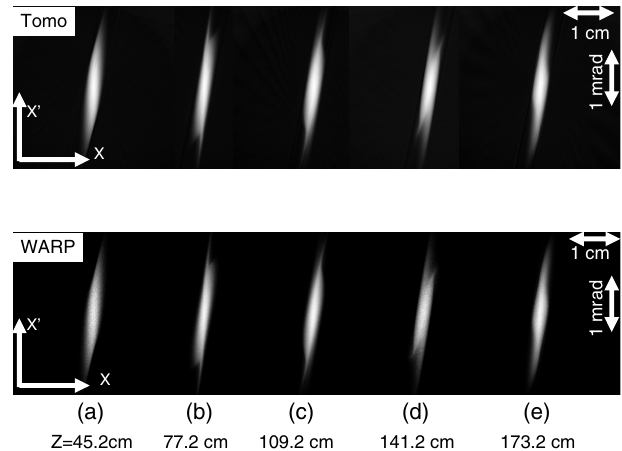
FIG. 10. Phase space from simulations of the 7 mA beam after propagating for different distances, clearly indicating the propa- gation of transverse density waves: tomography (top) vs direct WARP result (bottom) (cf. Ref. [19]). Phase space after passing through (a) 3; (b) 5; (c) 7; (d) 9; and (e) 11 quadrupoles.